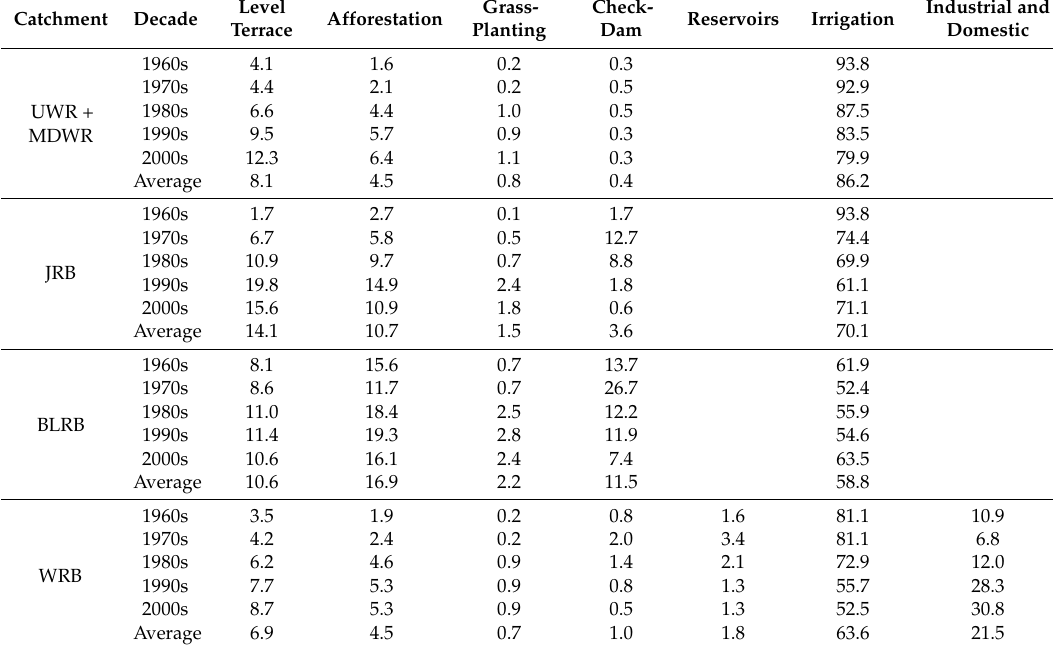
Table 4. The percentage contribution of soil and water conservation measures and water users to the streamflow reduction caused by direct human activities at the end of each decade (%).